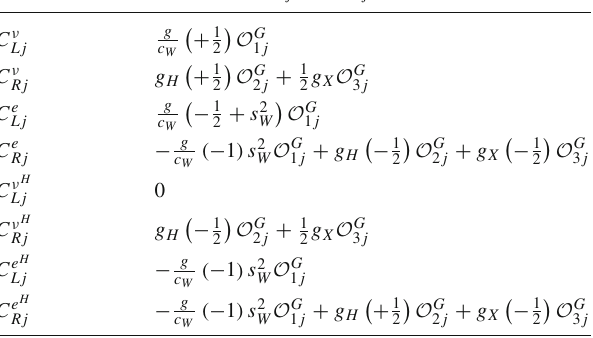
Table 3 Coupling coefficients C f